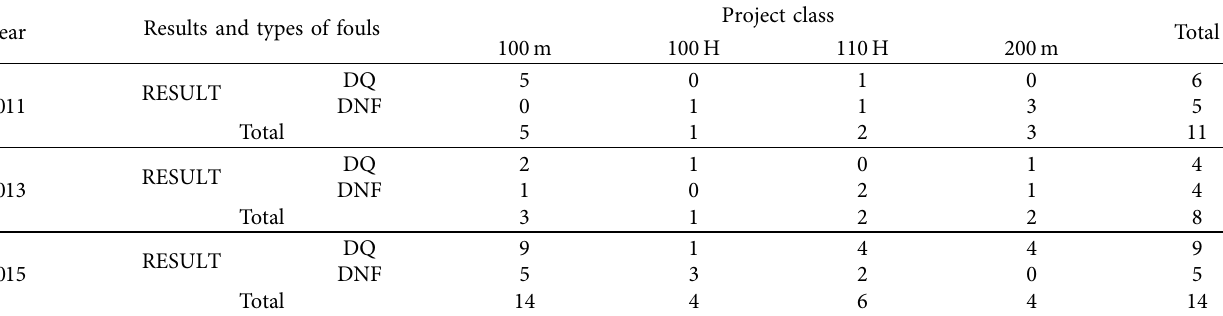
Table 9: Contingency table of foul type and race type.